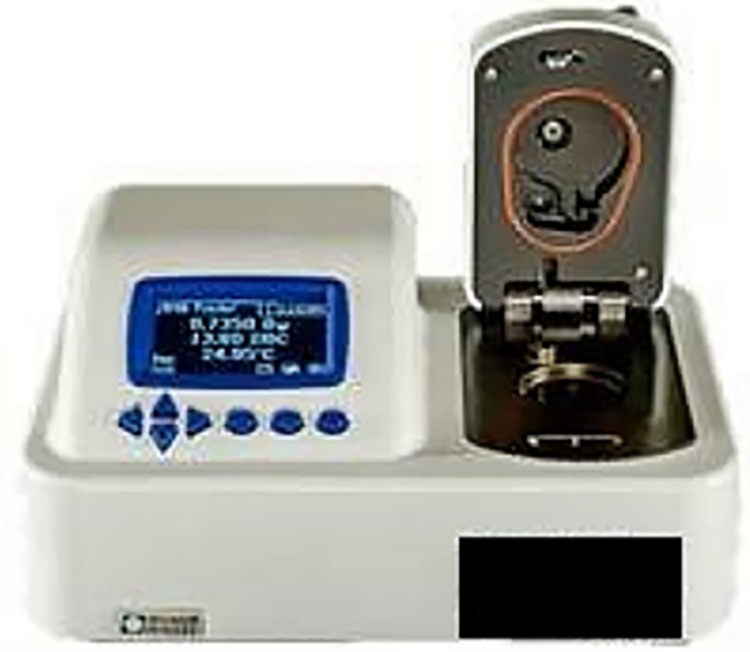
AQUALAB 4TEV equipment.